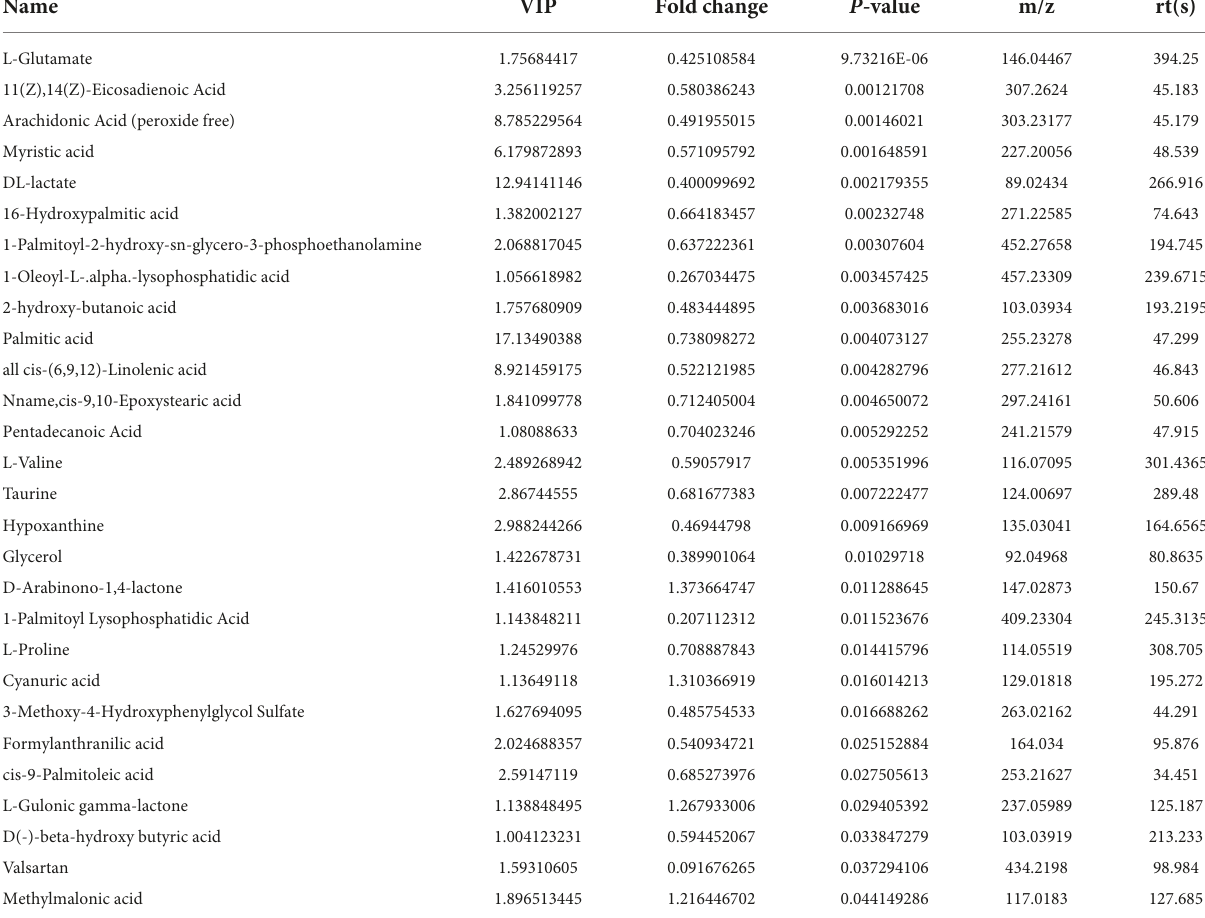
TABLE 3 Statistical analysis of different metabolites in negative ion